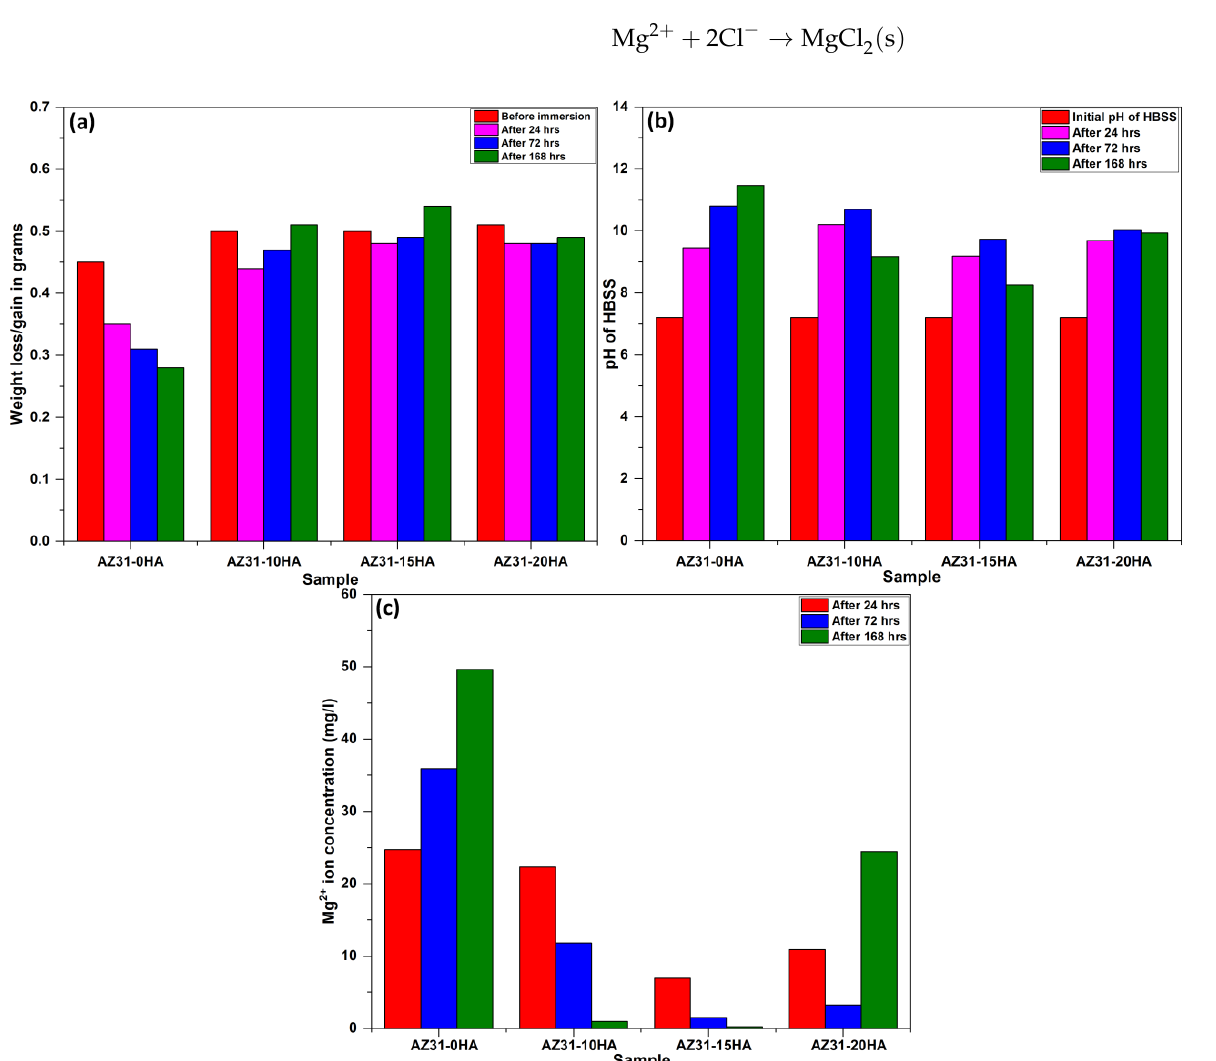
Figure 10. Results of immersion test in HBSS after 24, 72 and 168 h of exposure time ( a ) relative weight loss, ( b ) changes of pH value of HBSS and ( c ) changes of Mg 2+ ion concentration in HBSS.